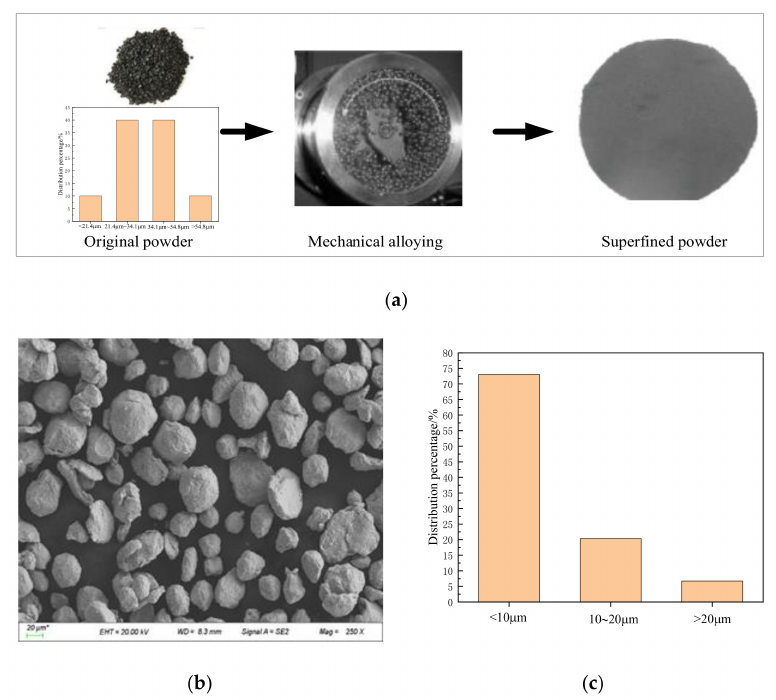
Figure 6. Original Inconel 718 superalloy powder and Inconel 718 powder and particle size distri- bution after ball milling: ( a ) original powders and alloying process; ( b ) Scanning electron micro- scope (SEM) image of powders after ball milling; ( c ) particle size distribution of Inconel 718 after ball